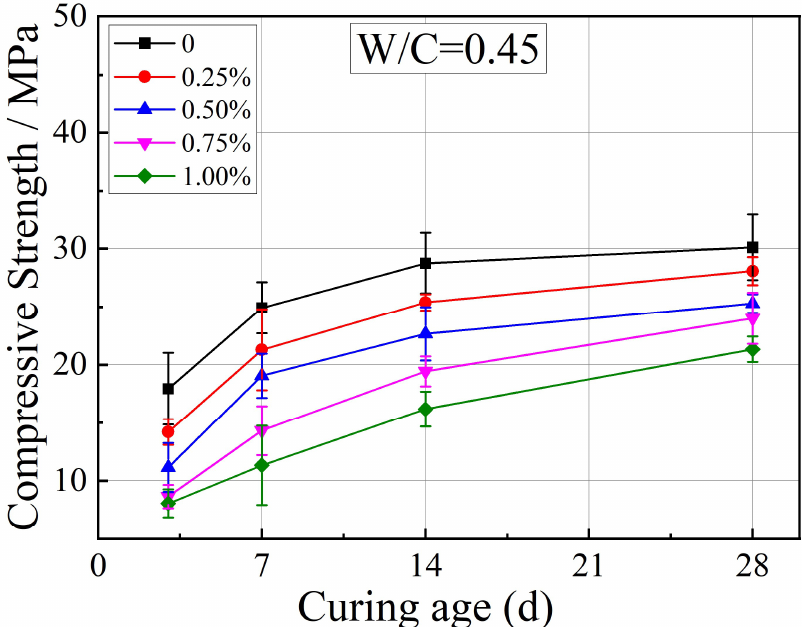
Figure 2. Unconfined compressive strength of samples with different W/C ratios (0.35, 0.4, and 0.45), ages (3 d, 7 d, 14 d, and 28 d), and SAP components (0%, 0.25%, 0.5%, 0.75%, and 1%).